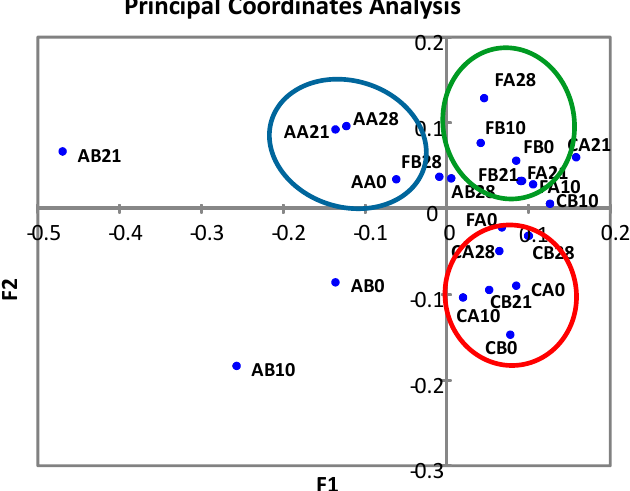
Figure 2. Principal coordinates analysis of Paipa cheese microbial composition. Cheese samples from three formal producers (C, A, F) corresponding to two independent batches (A and B) at different ripening times (0, 10, 21, 28 days) were analyzed. The ellipses indicate the clustering of the samples from producers C (red), A (blue) and F (green).